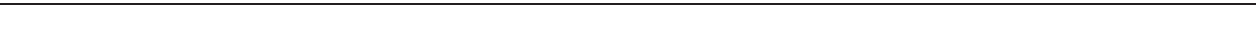
Fig. 4 CG pathway is abolished in the absence of IRSp53. a The box plot shows the number of endosomes per cells (left) for endocytosed GFP-GPI ( α -GFP Fab), fl uid phase and TfR in IRSp53 − / − and IRSp53 WT cells when pulsed for 2 min along with representative images (right). Data were pooled from two independent experiments and the number of cells indicated below the graph. b Plot (left) shows quanti fi cation of the fraction of GFP-GPI endocytic vesicles containing fl uid phase or Tf. Images (right) show representative single confocal slices of a 2-min pulse of α -GFP Fab (green)/TMR-Dextran (magenta) and α -GFP Fab (green)/A568-Tf (magenta) in IRSp53 − / − (top row) and IRSp53WT (bottom row) cells. The inset depicts magni fi ed views of the indicated region; single-channel images are in panel 4a. Data were pooled from two independent experiments and the number of cells is indicated below the graph. c Plot (left) showing quanti fi cation of the fraction of 1-min fl uid-phase endocytic vesicles containing Tf. Images show representative single confocal slices of a 1-min pulse of TMR-Dextran (green) and A647-Tf (magenta) in IRSp53 − / − (top row) and IRSp53WT (bottom row) cells. Inset depicts magni fi ed views of the indicated region. Data were pooled from two independent experiments and the number of cells indicated below the graph. d Histogram (left) shows 5-min uptake of fl uid phase in IRSp53 − / − MEFs transduced with virus expressing GFP-IRSp53 WT, GFP-IRSp53 4KE, GFP-IRSp53 I268N, GFP-IRSp53 I408P and GFP-IRSp53 V522G, normalised to that in IRSp53 − / − MEFs, along with representative images (right). Data were pooled from two independent experiments and the number of cells indicated in fi gure except for IRSp53 − / − (381). p value <0.01 (*) and 0.001(**) by Mann – Whitney U test ( a – d ). Scale bar, 20 µ m ( d ), 5 µ m ( a – c ), respectively. Error bars ( d ) represent